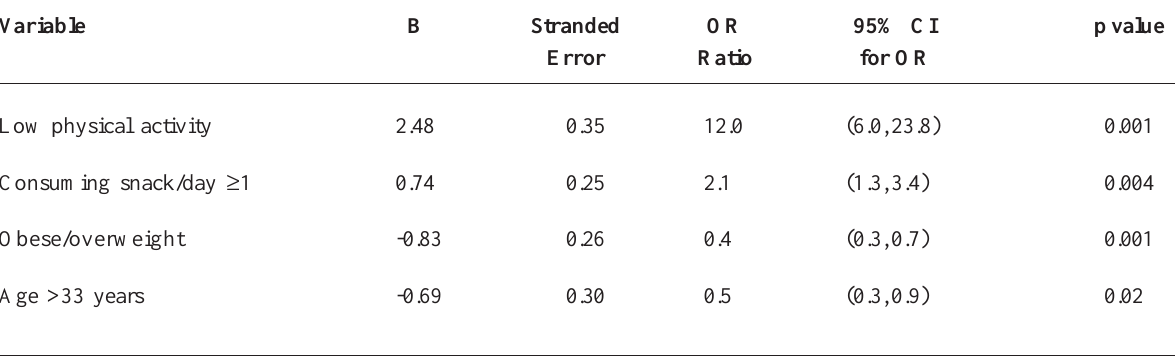
Table 2. Adjusted odds ratios for the association with weight